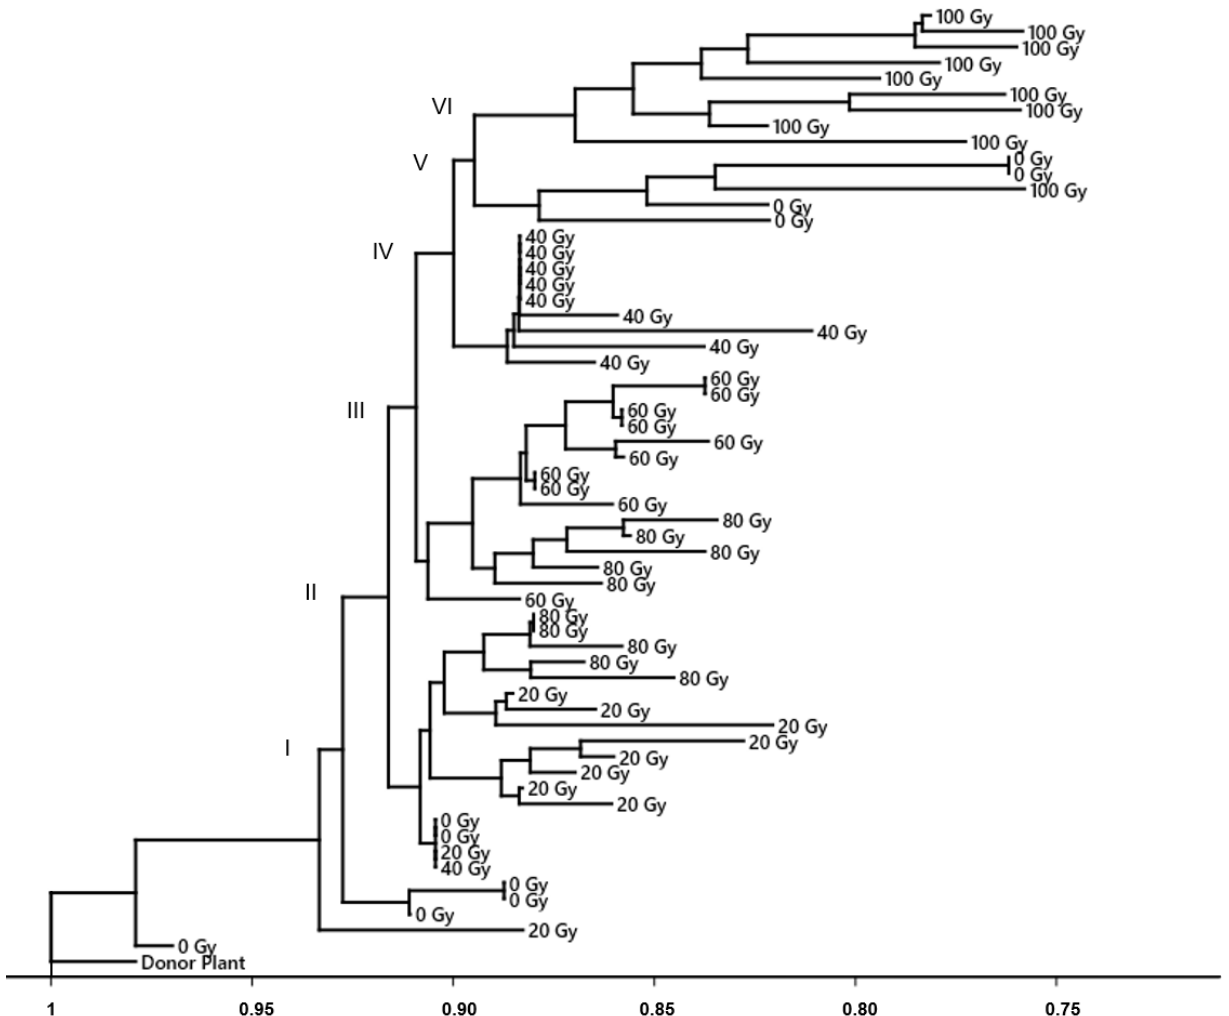
Figure 4. Neighbor joining dendrogram based on Jaccard’s coefficient, calculated for each gamma irradiation dose with respect to the donor plant of vanilla ( Vanilla planifolia Jacks. ex Andrews). The values under line represent: 1 similarity, and 0 divergence. I-VI: subgroups with different similarity distances.